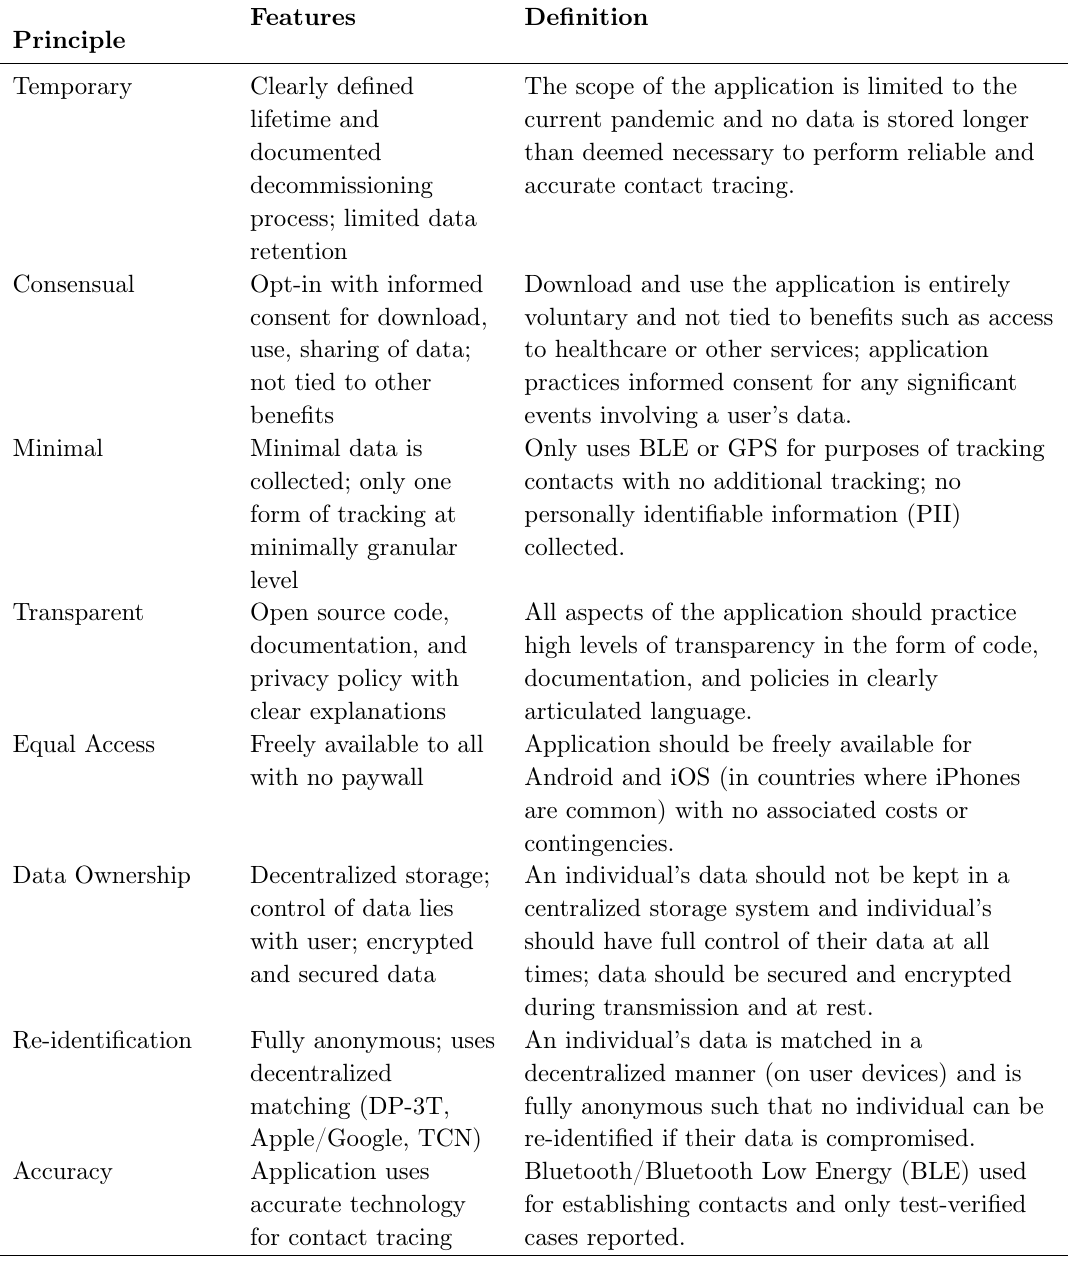
Table 1. Principles and definitions for scoring